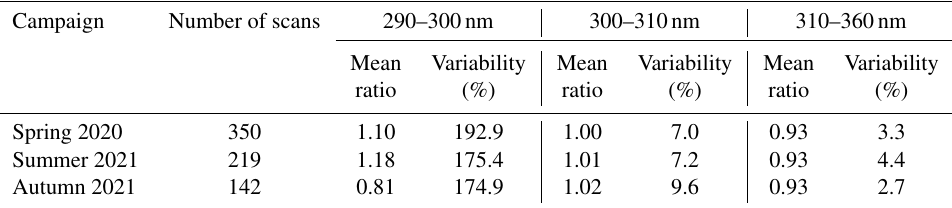
Table 2. Summary statistics of the three measurement campaigns with the BTS spectroradiometer relative to the double Brewer spectrometer. The variability is defined as the difference between the 5th and the 95th percentile of all